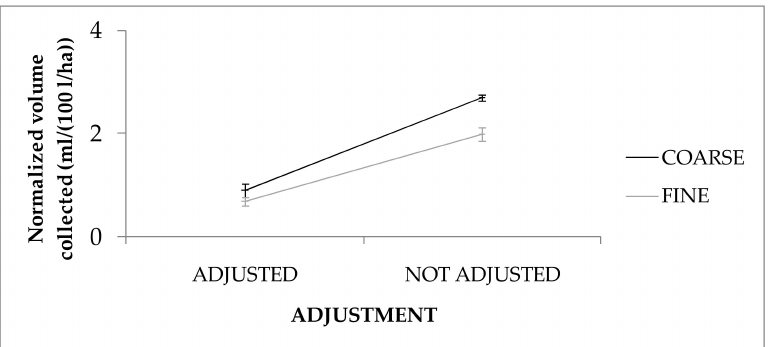
Figure 25. Adjustment × Nozzle type interaction effect on the normalized volume collected above the Canopy height (mean ± SE) with the C2